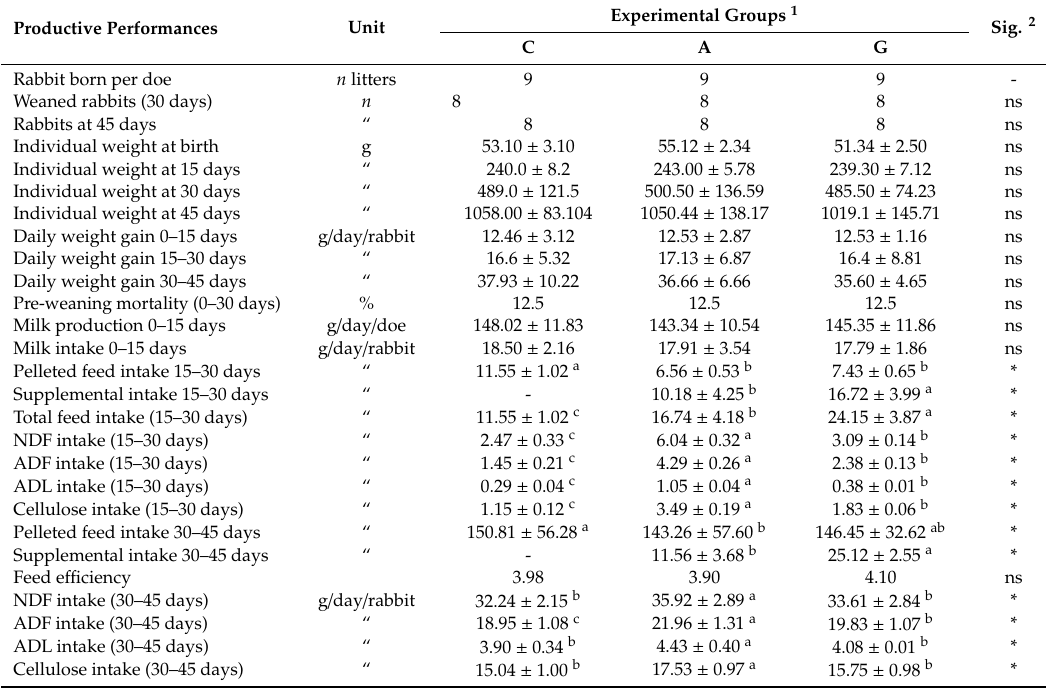
Table 2. E ff ect of dehydrated alfalfa or fresh grass supplementation on productive performance of rabbit does and young